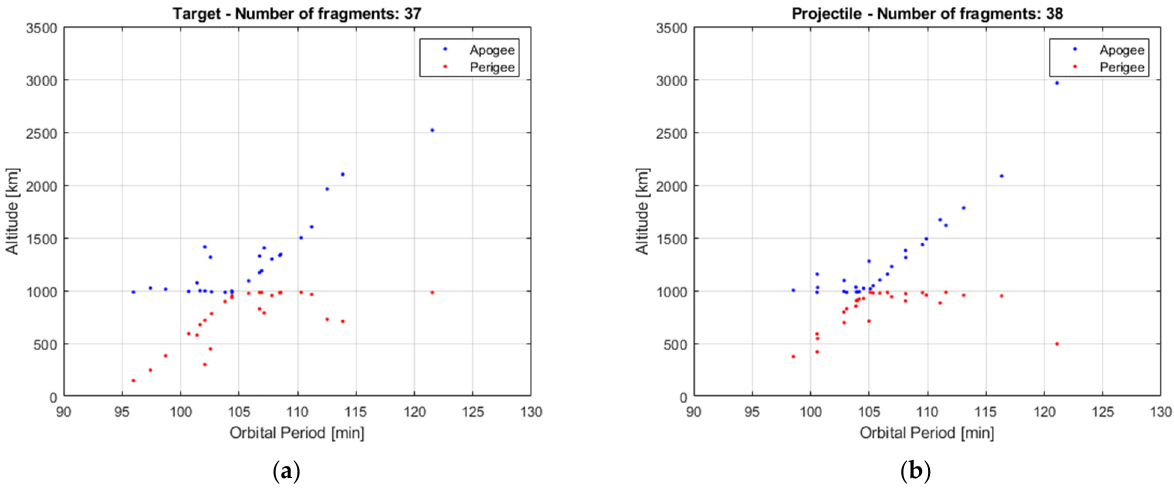
Figure 16. Gabbard diagrams for the target ( a ) and the projectile ( b ), obtained with input masses equal to m 1 = 30 kg and m 2 = 30 kg.